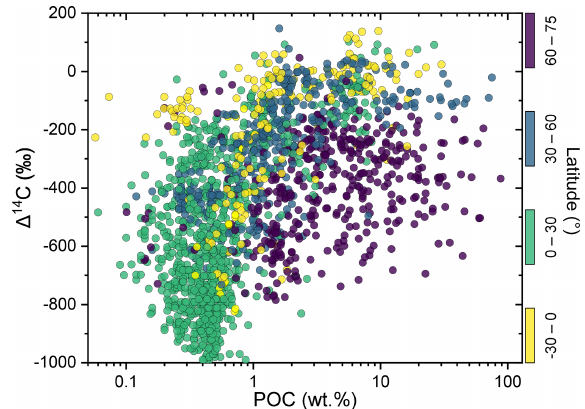
Figure 7. (cid:49) 14 C values versus POC content ( n = 1860). Colors in- dicate the latitude of the sampling location. Note the log scale used for the POC